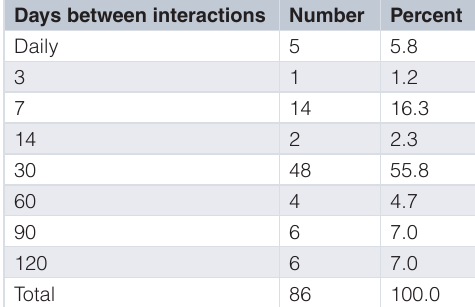
Table 6. Frequency of community health worker (CHW) supervision